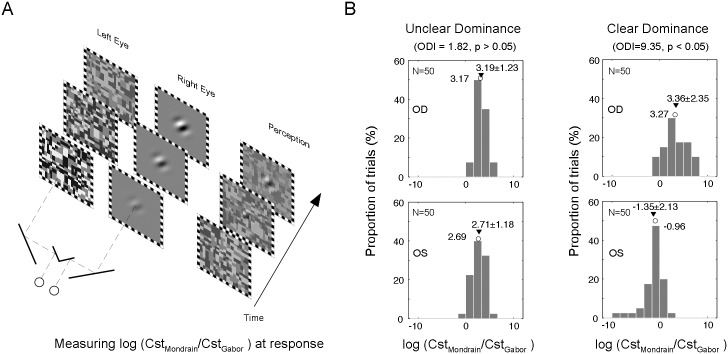
The method to measure ocular dominance index (ODI).(A) The log(CstMondrian/CstGabor) was calculated at response for each trial and each eye was tested 50 times. (B) T-test was used to compare the log ratios collected from the two eyes and the t-value was used as the ODI. Examples of subjects with unclear dominance (ODI < 2, left panel) and clear dominance (ODI ≥ 2, right panel) are shown here. Circles and triangles represent median and mean of the log ratios respectively.